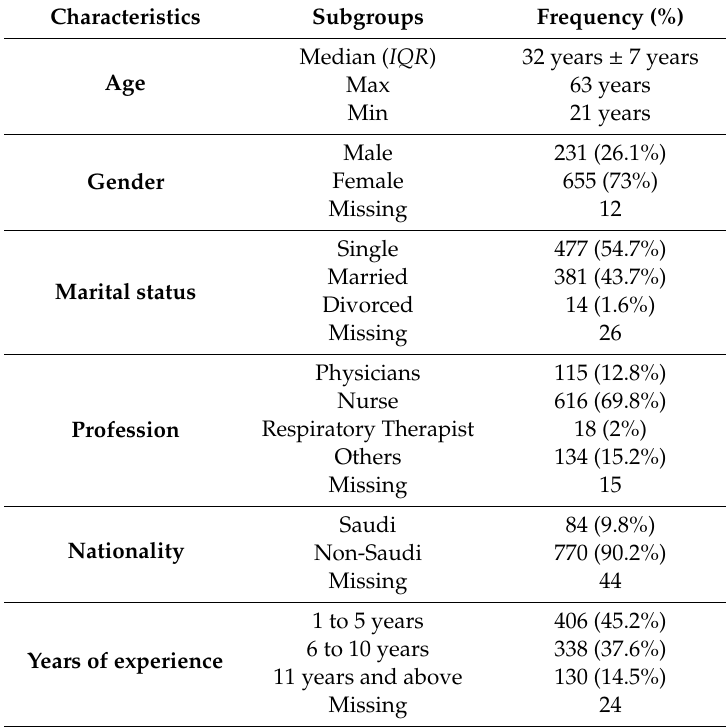
Table 1. Sociodemographic characteristics of participants (n =